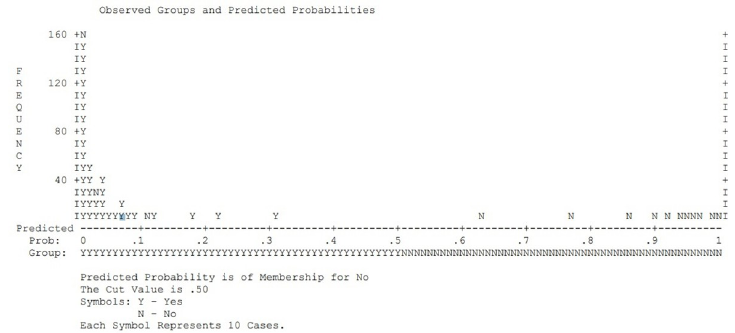
Fig 4. Predicted probabilities. Piling of the data responses and predicted probabilities on both sides of the figure explains a good outcome related to the variables and the model.